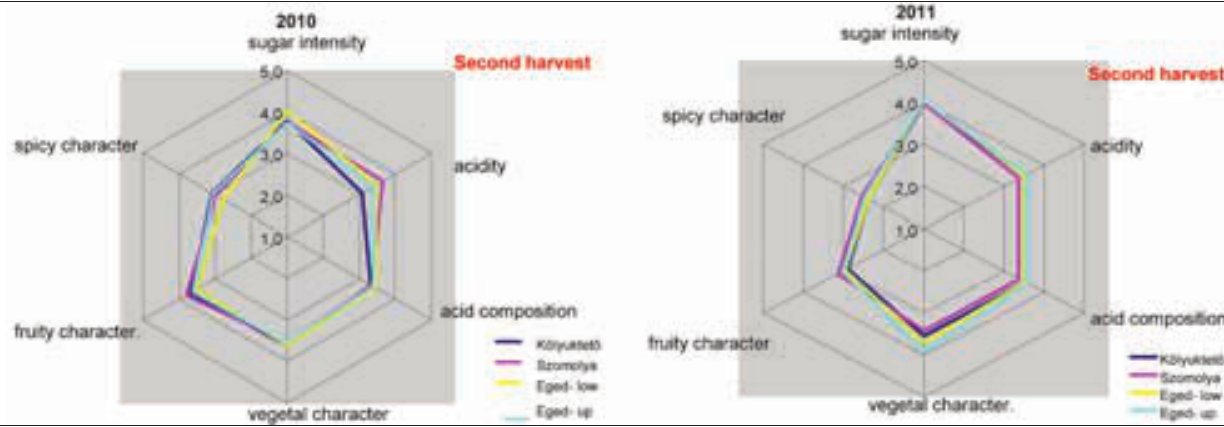
Figure 2b: Main sensorial characters of the pulp (2010-2011- Second harvest time)